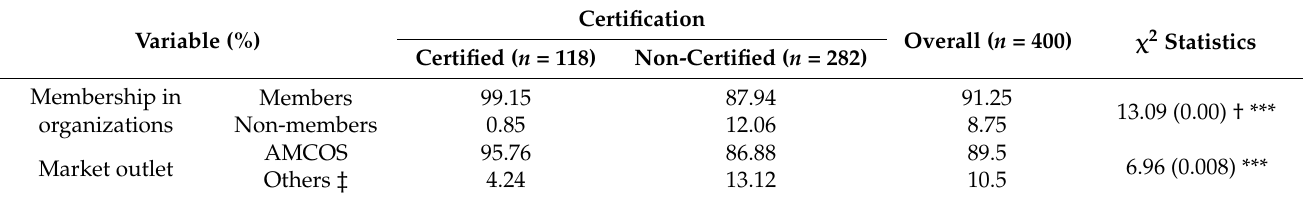
Table 3. Participation in collective action and points of sale among coffee